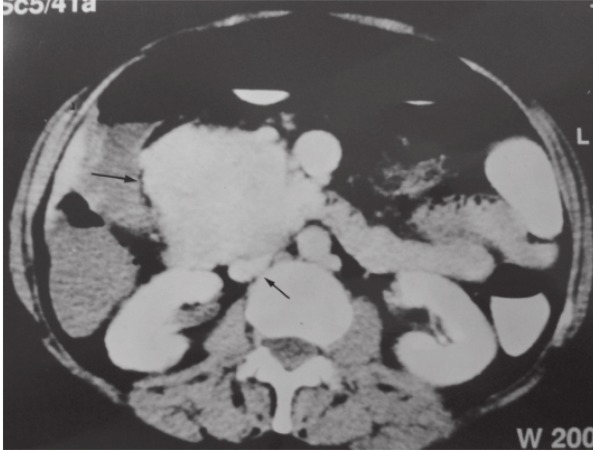
Figure 1 - Computed tomography of the abdomen with a solid mass (large arrow) in the area at the level of the head of the pancreas, showing the proximity between the mass and the inferior vena cava (small arrow)